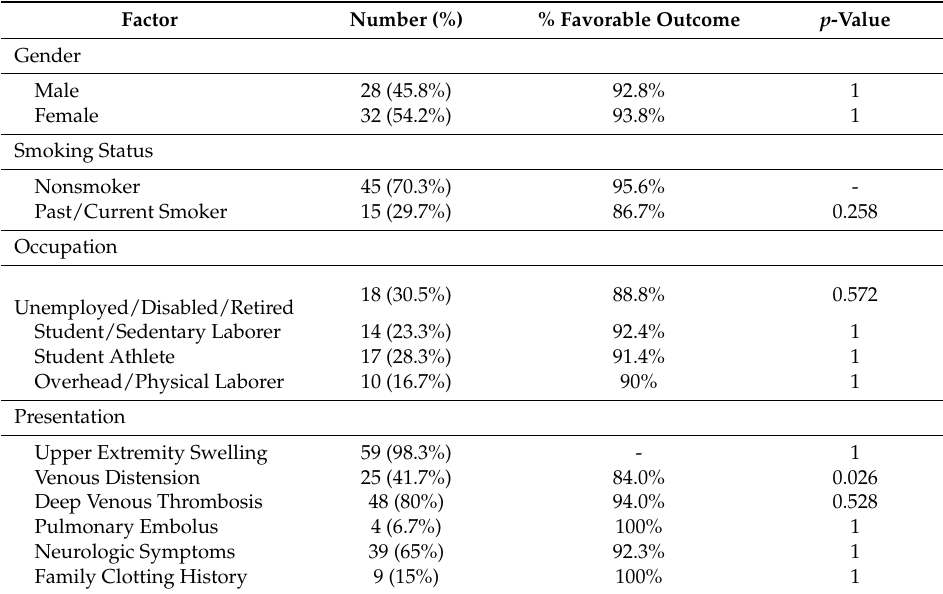
Table 1. Association of patient presentation variables with surgical